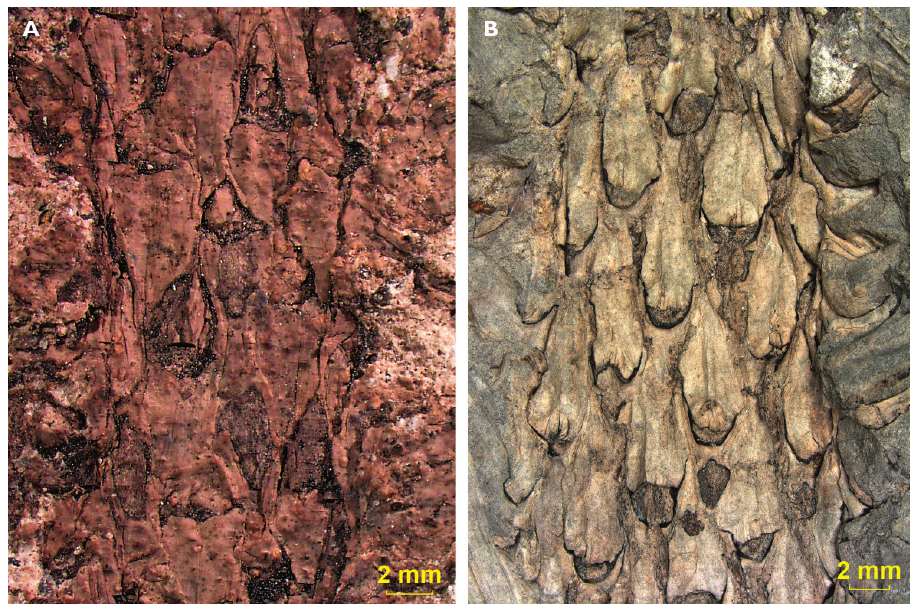
Figure 4. Variations in leaf cushion organisation: A Leaf cushion organisation in a specimen with a relatively dominant basal leaf cushion field, Sample E 06944, Lubná B Leaf cushion organisation in a specimen with relatively dominant apical leaf cushion field, Specimen 223, Mt